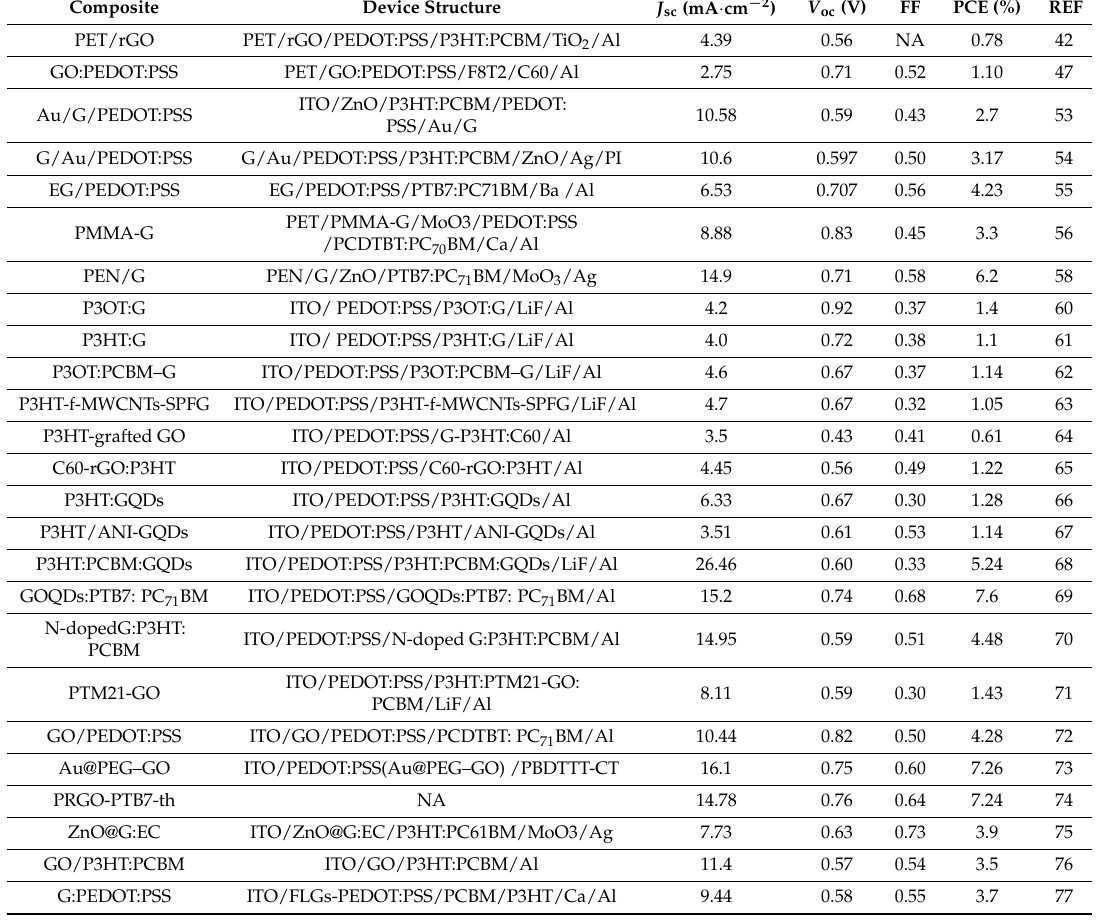
Table 1. Characteristics of PSCs based on G/polymer